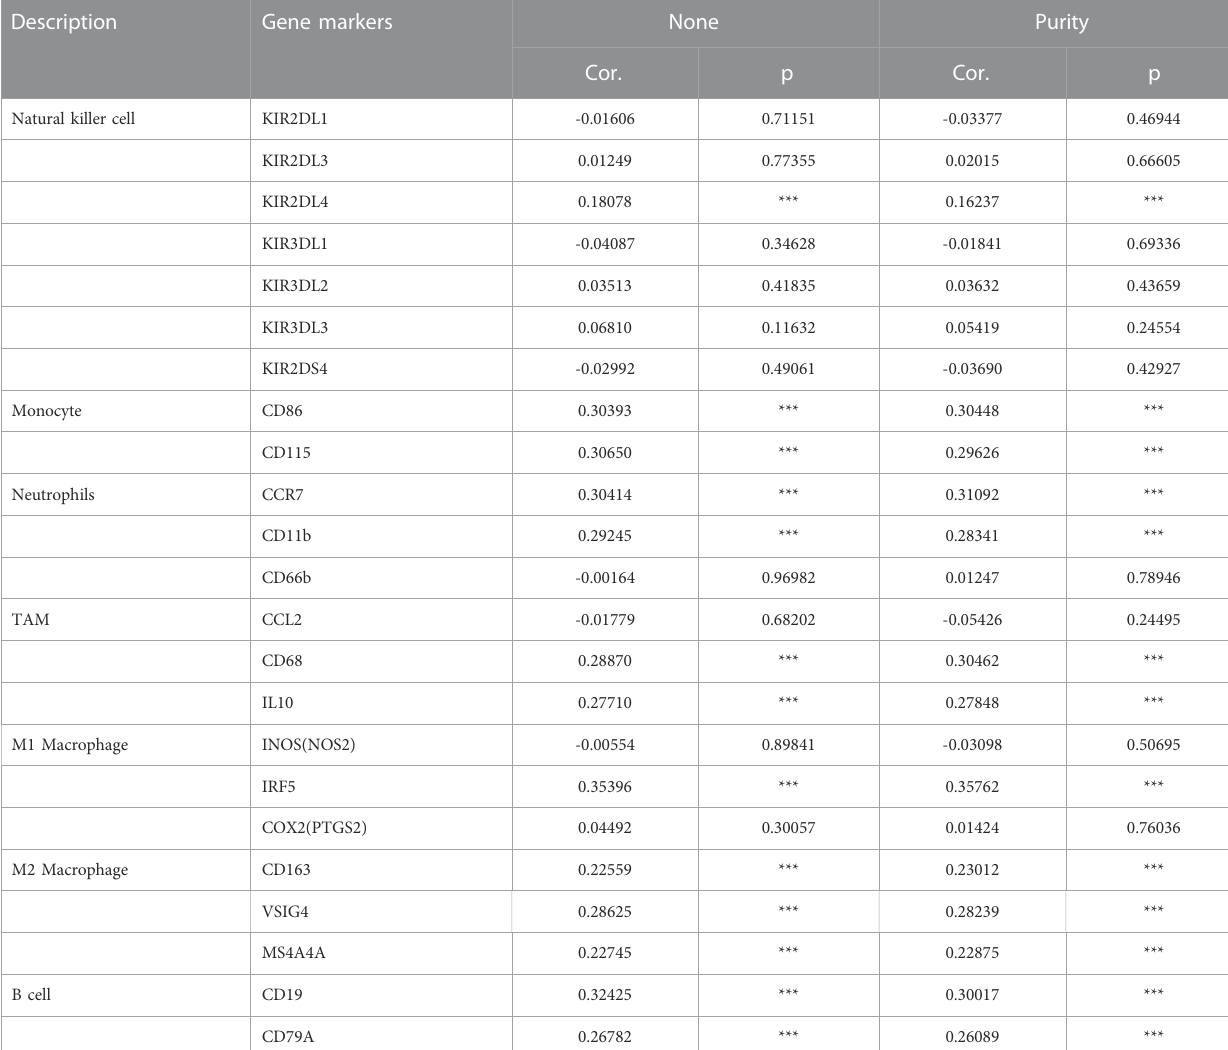
TABLE 4 ( Continued ) Correlations between GTSE1 and gene markers of immune cells in